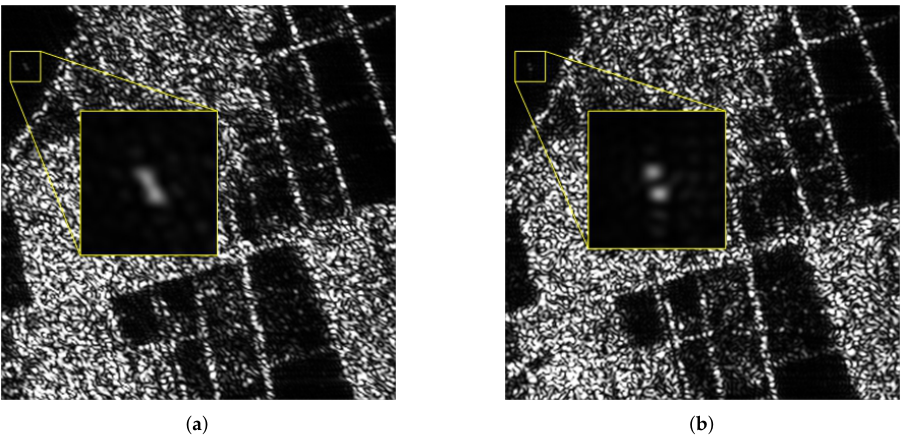
Figure 25. Extended-target images focused by ( a ) constant parameter and ( b ) continuously time- varying